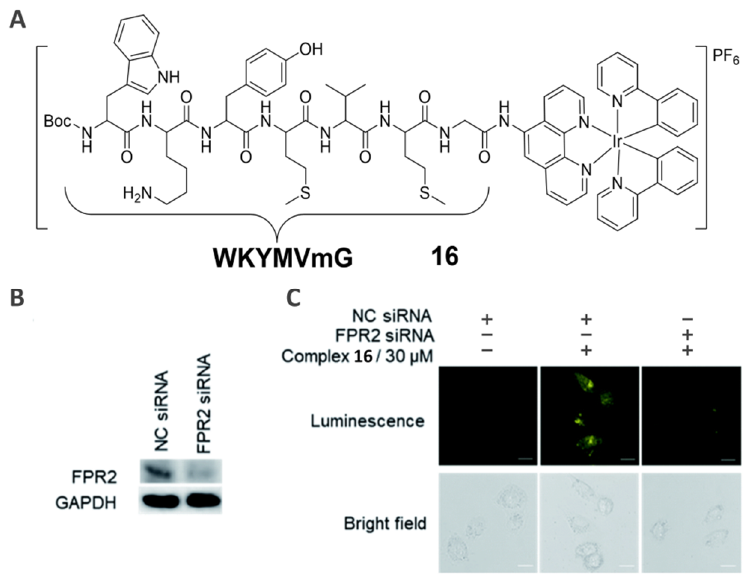
Figure 11. ( A ) Chemical structure of complex 16 . ( B ) FPR2 expression after the treatment of FPR2 siRNA. GAPDH was used as a loading control. ( C ) Normal HUVEC cells and FPR2 knockdown HUVEC cells were stained with or without complex 16 (30 µ M) for 1 h. Reproduced with permission from ref. [83]. Copyright 2018 Royal Society of Chemistry.